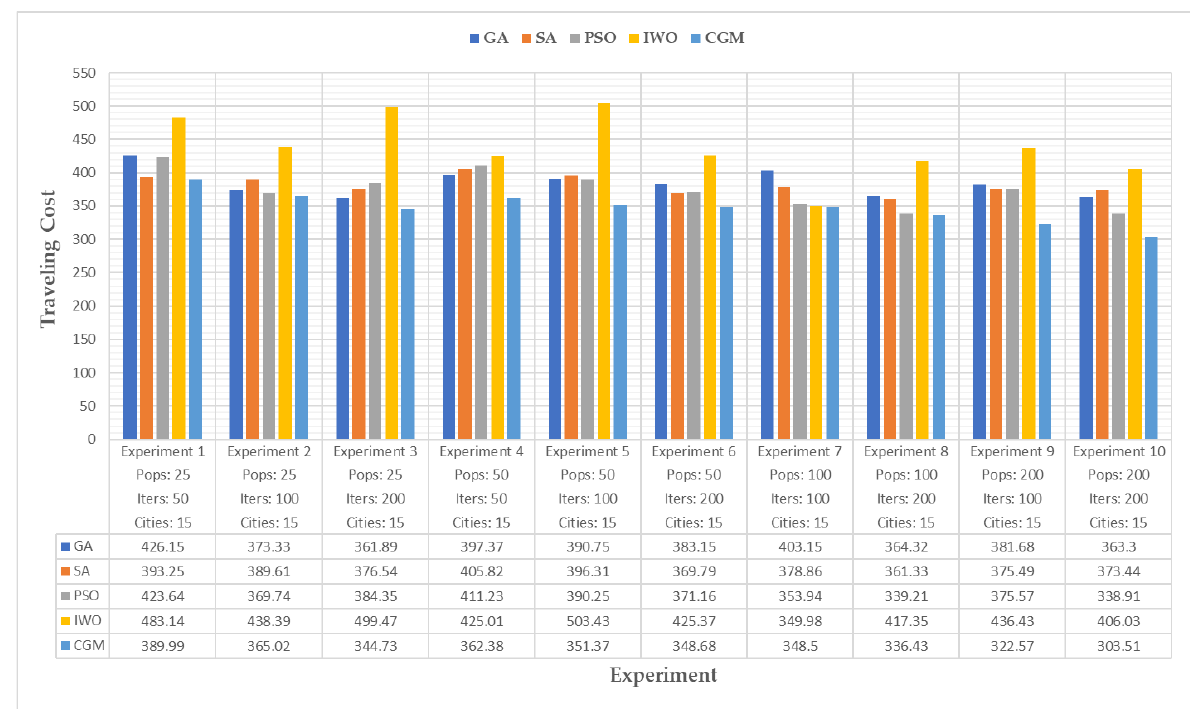
Figure 5. Evaluation results of the traveling salesman problem (ATT48 dataset).